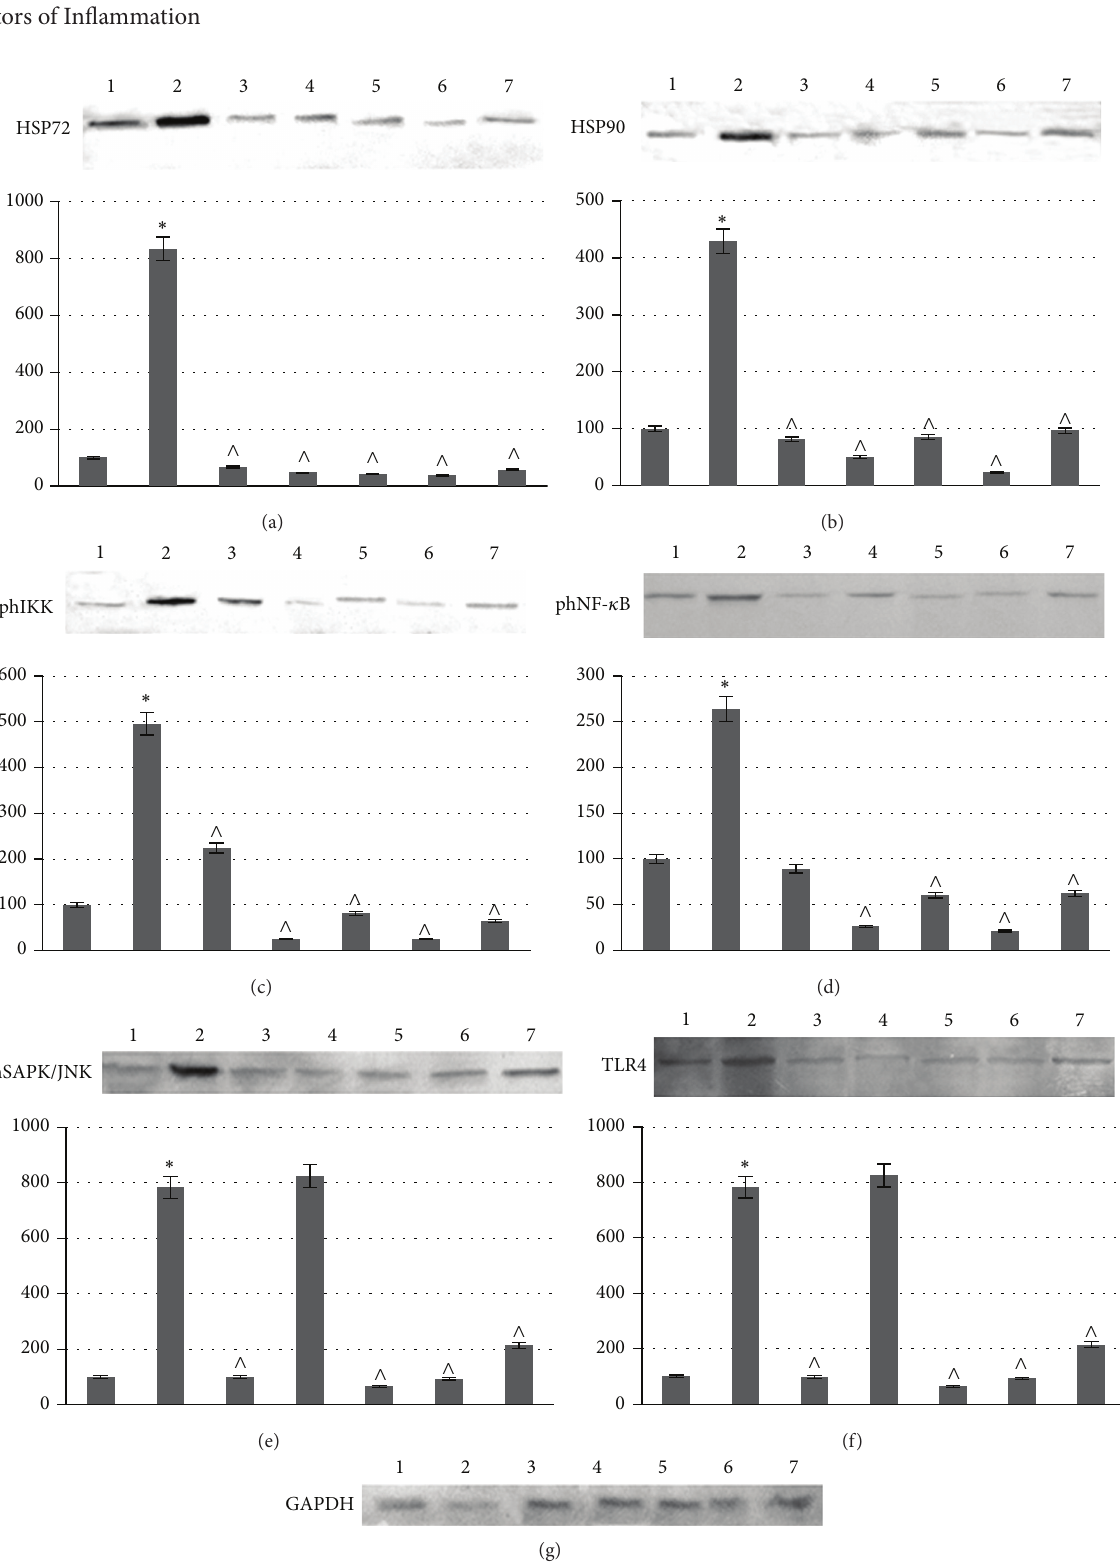
Figure 2: The effects of IKK Inhibitor XII and antioxidant-rich diet on phosphorylation of RelA, IKK, and SAPK/JNK and on the expression of TLR4 and heat shock proteins in the splenic lymphocytes from inflammation-bearing mice. The animal’s groups that was indicated in Figure 1 were used (1, control; 2, IB mice; 3, IB + Inh5; 4, IB + Inh10; 5, IB + Inh20; 6, IB + diet; 7, IB + diet + Inh20). Western blot analysis of extracts from isolated mice lymphocytes was provided using corresponding antibodies or anti-GAPDH antibody (bottom). Blot pictures show a single representative experiment from four independent experiments. Histograms below protein bands show protein levels calculated as mean relative units correspondingly to internal control and are the results of blots densitometry by program QAPA from four independent experiments. ∗ Significantly different from control, 𝑃 < 0.05 . ∧ Significantly different from LPS-group, 𝑃 < 0.05